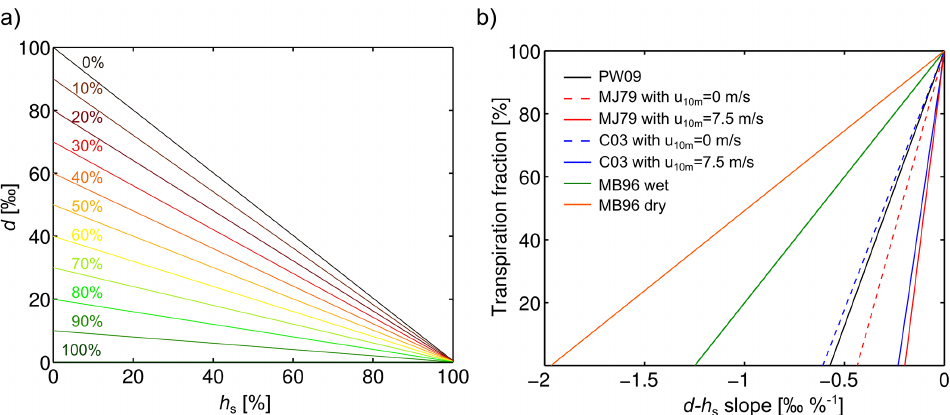
Fig. 12. (a) The d – h s relations obtained using the Craig and Gordon (1965) evaporation model assuming closure for different fractions of transpiration contributions to continental evaporation (colours). The non-equilibrium fractionation factors for wet soils (see Table 1, Mathieu and Bariac, 1996) were used here. (b) Theoretical linear relationship between the transpiration fraction and the slope of the d – h s relation using the Craig and Gordon (1965) evaporation model and applying the closure assumption for T s = 25 ◦ C. The different lines correspond to the use of different non-equilibrium fractionation factors. PW09 stands for Pfahl and Wernli (2009), MJ79 for Merlivat and Jouzel (1979), C03 for Cappa et al. (2003), and MB96 for Mathieu and Bariac (1996). For the estimates of the transpiration fraction in Tables 5 and 6 the non-equilibrium factors for wet soils (see Table 1, Mathieu and Bariac, 1996) are used for soil evaporation and the non-equilibrium fractionation factors of Pfahl and Wernli (2009) are applied for ocean